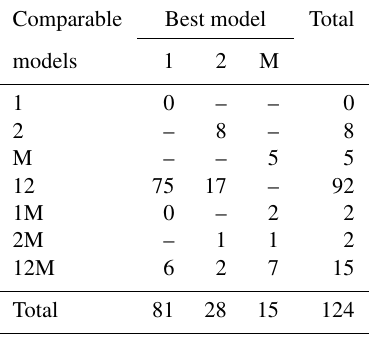
Table 3. Shows the best and acceptable models for the 124 individ- ual forest plots for trunk diameter. Models are labelled as “M” for MST, “1” for the one-parameter DET-LTWD and “2” for the two- parameter DET-LTWD. Columns refer to best-fitting model (lowest BIC score). Rows refer to models that are so good a fit compared to the best that they cannot be rejected, as their BIC score is so close to the best model. For example “1M” means the MST and one-parameter models are not rejected but the two-parameter model is rejected based on BIC. Then the columns in this row show how many forest plots have either the 1 or M model as the best